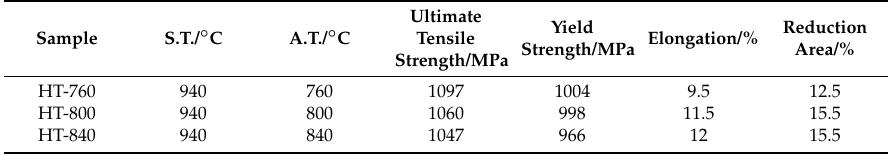
Table 3. Room temperature tensile properties of the Ti-22Al-25Nb alloy